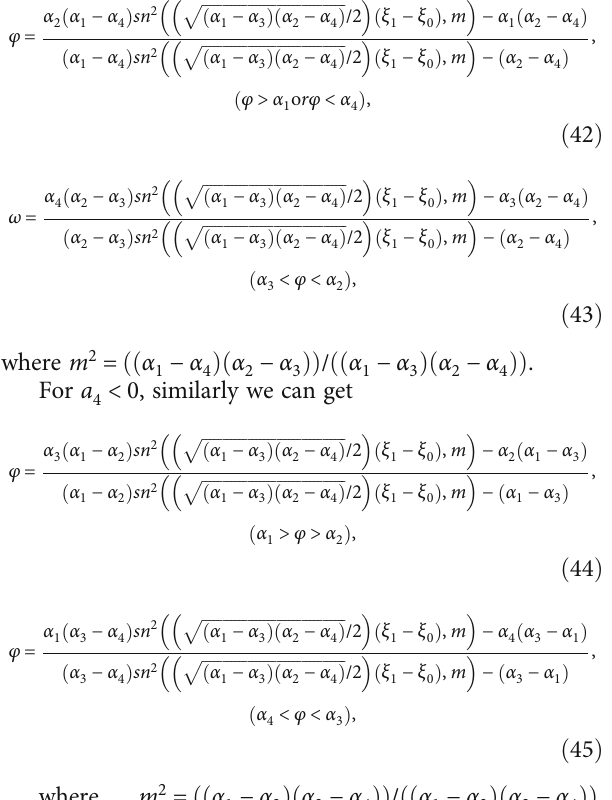
ffiffiffiffiffiffiffiffiffiffiffiffiffiffiffiffiffiffiffiffiffiffiffiffiffiffi ∓ 2 sm